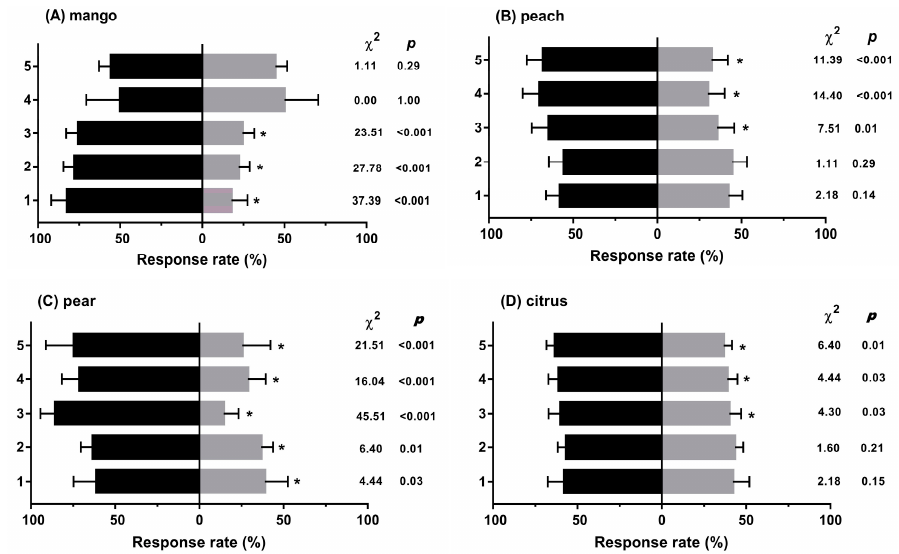
Figure 1. Behavioural responses of F. arisanus females to diverse fruit species with different treatments under a dual choice test. ( A ) mango, ( B ) peach, ( C ) pear, ( D ) citrus. The data are expressed as mean ± SD. Numbers 1 to 5 in the Y-axes of all panels refer to: ( 1 ) noninfested fruit vs. purified air; ( 2 ) mechanically damaged fruit vs. purified air; ( 3 ) infested fruit vs. purified air; ( 4 ) infested fruit vs. noninfested fruit; ( 5 ) infested fruit vs. mechanically damaged fruit (black bar vs. grey bar, respectively). Asterisks denote statistical differences using a Chi-square test ( p < 0.05). N = 9.